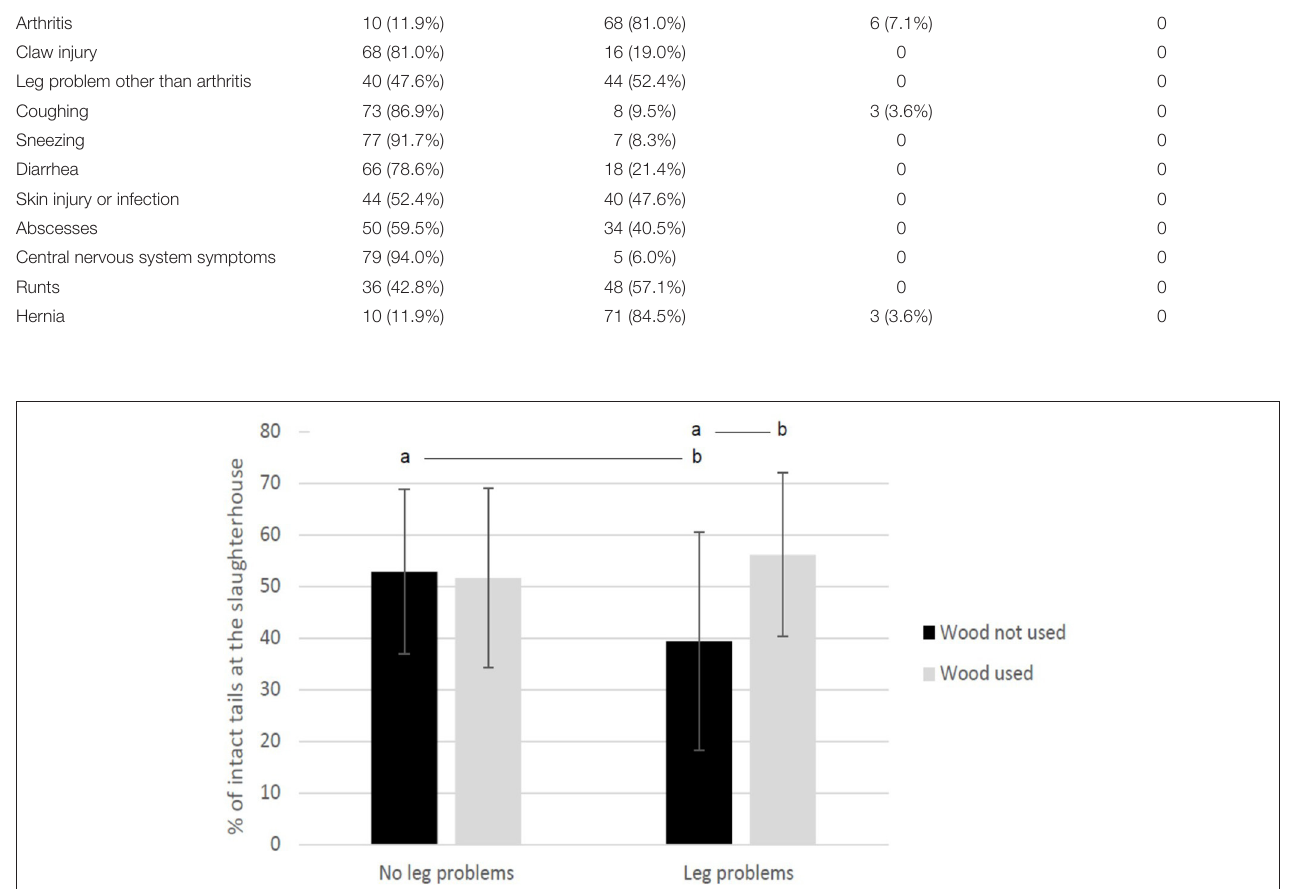
interaction “Wood as enrichment × Explorative behavior” ( df = 1, F = 7.086, and p = 0.009). Using of wood as enrichment was associated with fewer tails with major wounds, especially in herds where the pigs were recorded to show explorative behavior toward enrichment material ( Figure 6